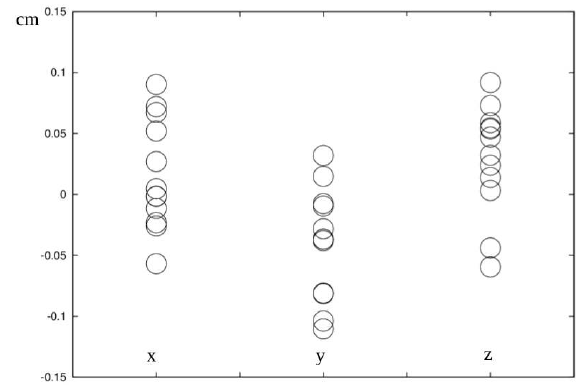
Figure 6: Mean of the differences between photogrammetric co- ordinates and electro-magnetically determined reference coordi- nates m x , m y , and m z of the screw heads in cm